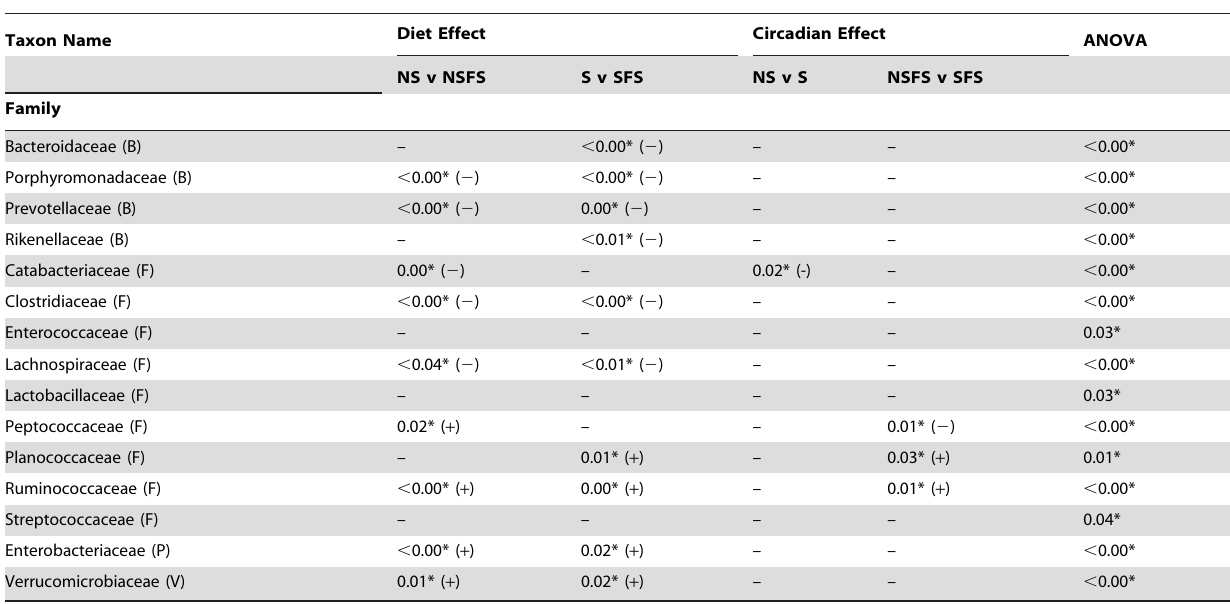
Table 4. Significant between group comparisons by taxon